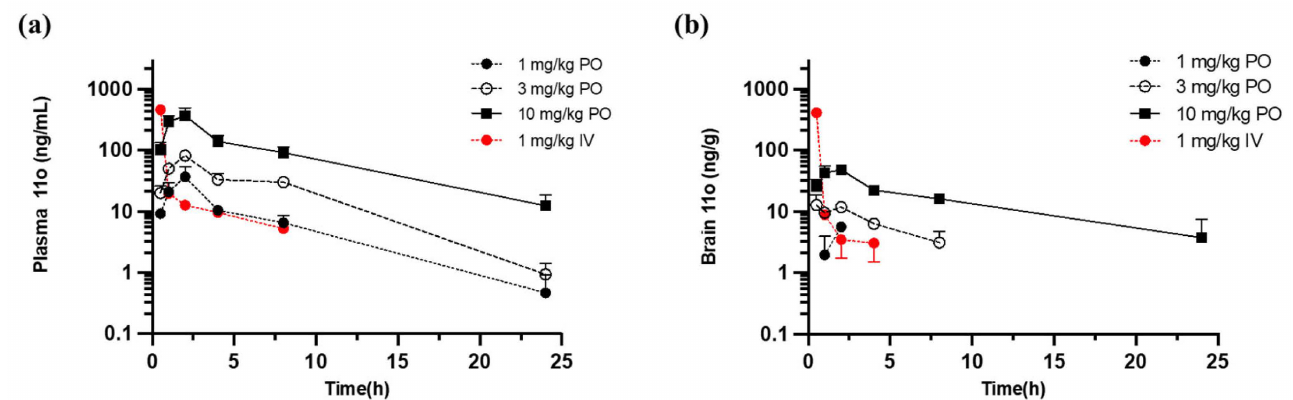
Figure 6. Plots showing the mean concentrations of 11o versus time in mouse plasma ( a ) and brain ( b ). 11o was administered either orally (PO) or intravenously (IV). Three mice were sampled from each group for blood and brain collection at each time point. Plasma and brain samples were analyzed for 11o concentrations using LC–MS/MS.